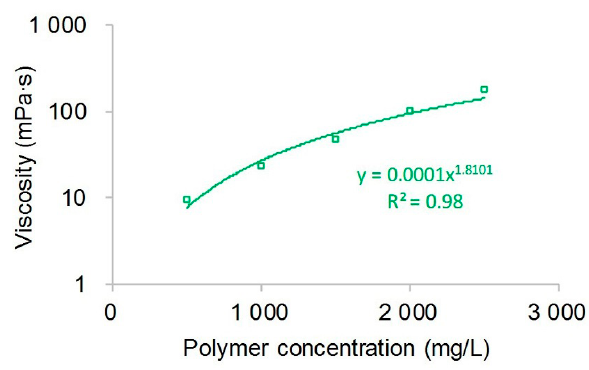
Figure 4. The relationship between the viscosity of the polymer solution and polymer concentration.